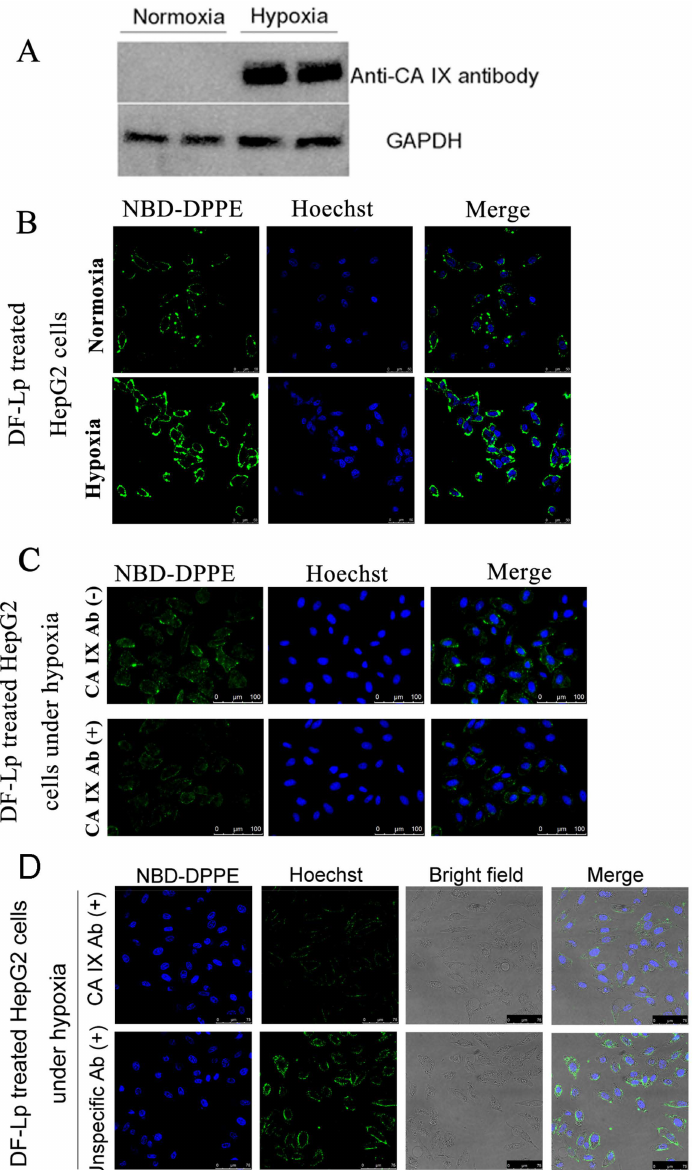
Figure 3. ( A ) Western blot analysis of CA IX expression in hypoxic and normoxic HepG2 cells. ( B ) Fluorescent images of CA IX positive HepG2 under hypoxic and CA IX negative HepG2